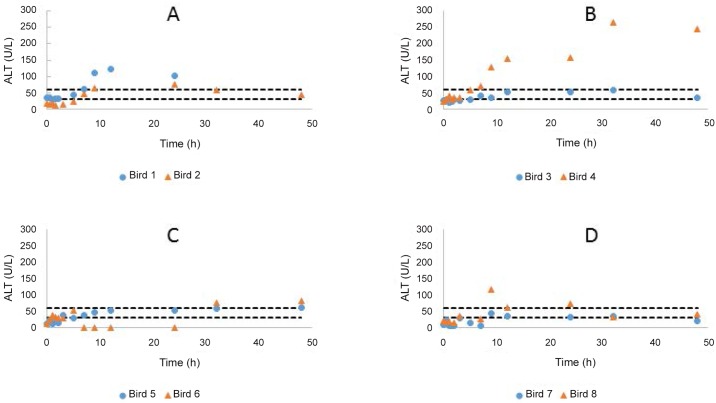
Changes in ALT activity over time for the individual birds treated with carprofen (A), Flunixin (B), Phenylbutazone (C) in comparison to the controls (D).The dotted lines represent the population upper and lower tolerance.